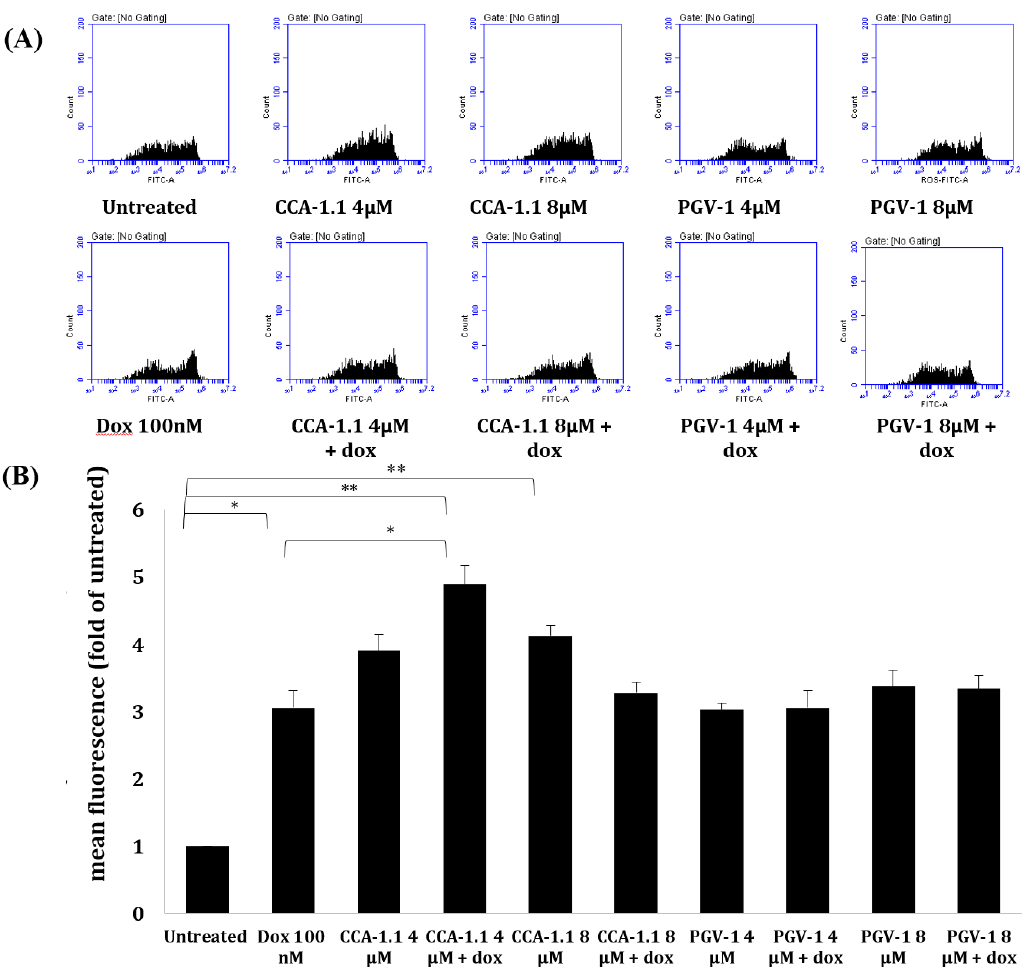
Figure 5. Effects of CCA-1.1, PGV-1, and CCA-1.1 + doxorubicin (Dox) on intracellular ROS accumulation in T47D cells. (A) Flow cytograms and (B) graph of ROS levels. Cells (5 × 10 4 cells/well) were incubated with CCA-1.1 or PGV-1 at a concentration of 4 or 8 µM for 4 h and stained with DCFDA. ROS measurement was carried out by flow cytometry. The data are presented as mean fluorescence ± SE ( n = 3). Differences among treatments were analyzed using Student’s t -test (* p < 0.01; ** p <